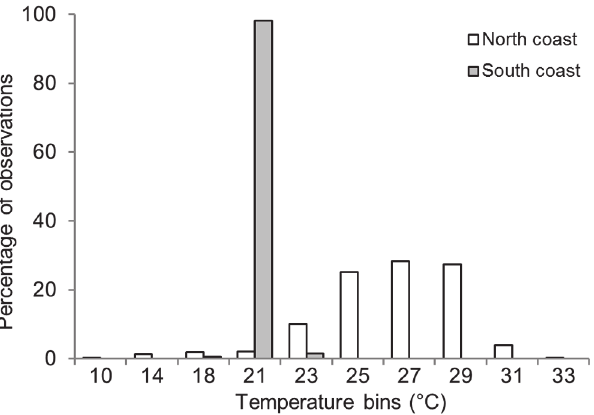
Fig 4. Latitudinal variation of temperature profiles for Shark 5. Percentage of time spent in each temperature bin at each region of Western Australia for Shark 5.